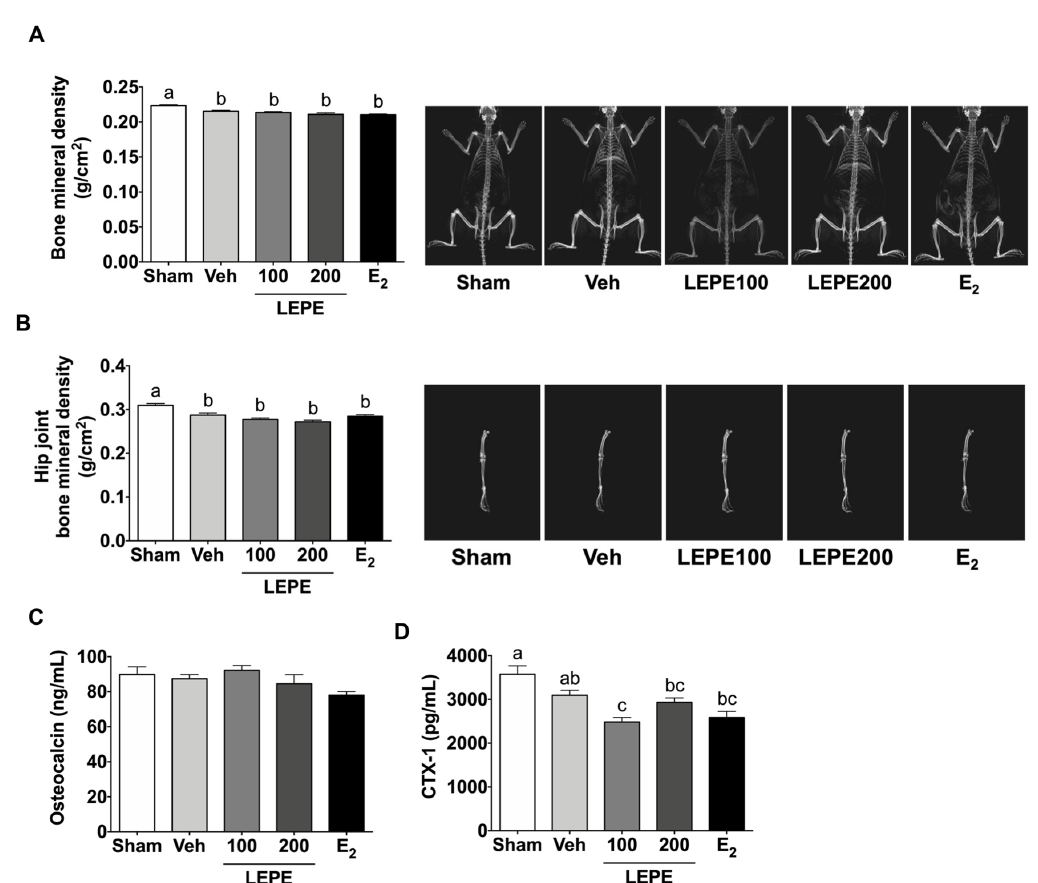
Figure 2. The effect of LEPE on menopause-related osteoporosis in body composition and blood. ( A ) BMD (bone mineral density), ( B ) hip joint BMD, ( C ) osteocalcin, and ( D ) CTX-1 (C-terminal telopeptide of type 1 collagen). Sham, control sham-operated rats; Veh, ovariectomized (OVX) rats treated with vehicle; LEPE100, OVX rats treated with Leonurus japonicus Houtt, Eclipta prostrata L., and Pueraria lobata Ohwi extract (LEPE) 100 mg/kg bw; LEPE200, OVX rats treated with LEPE 200 mg/kg bw; E 2 , positive control, OVX rats injected with estradiol 3.0 μ g/kg bw. Data are shown as mean ± SEM ( n = 12). a–c Significant differences were analyzed by one-way ANOVA with Tukey’s multiple comparisons between groups ( p < 0.05).